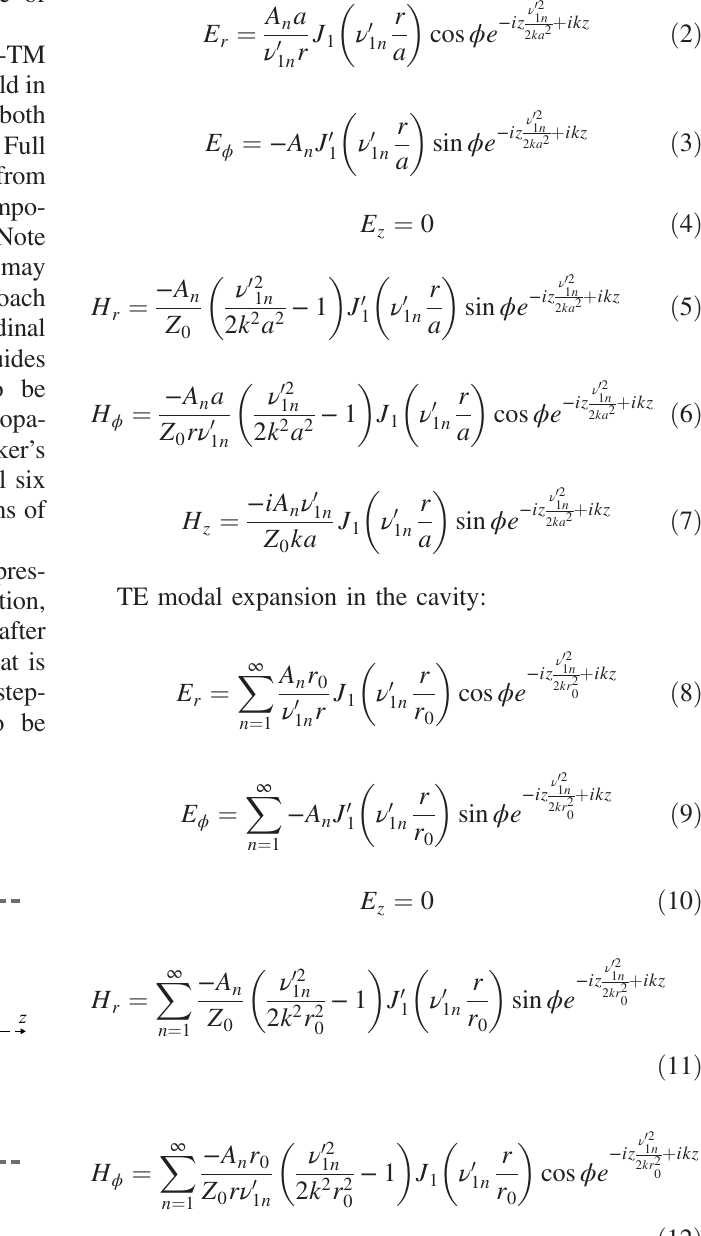
FIG. 2. One cell of the iris line and regions of